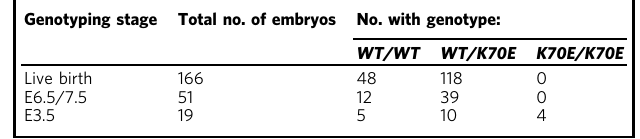
Table 1 Genotypes of offspring from Csn2 WT/K70E